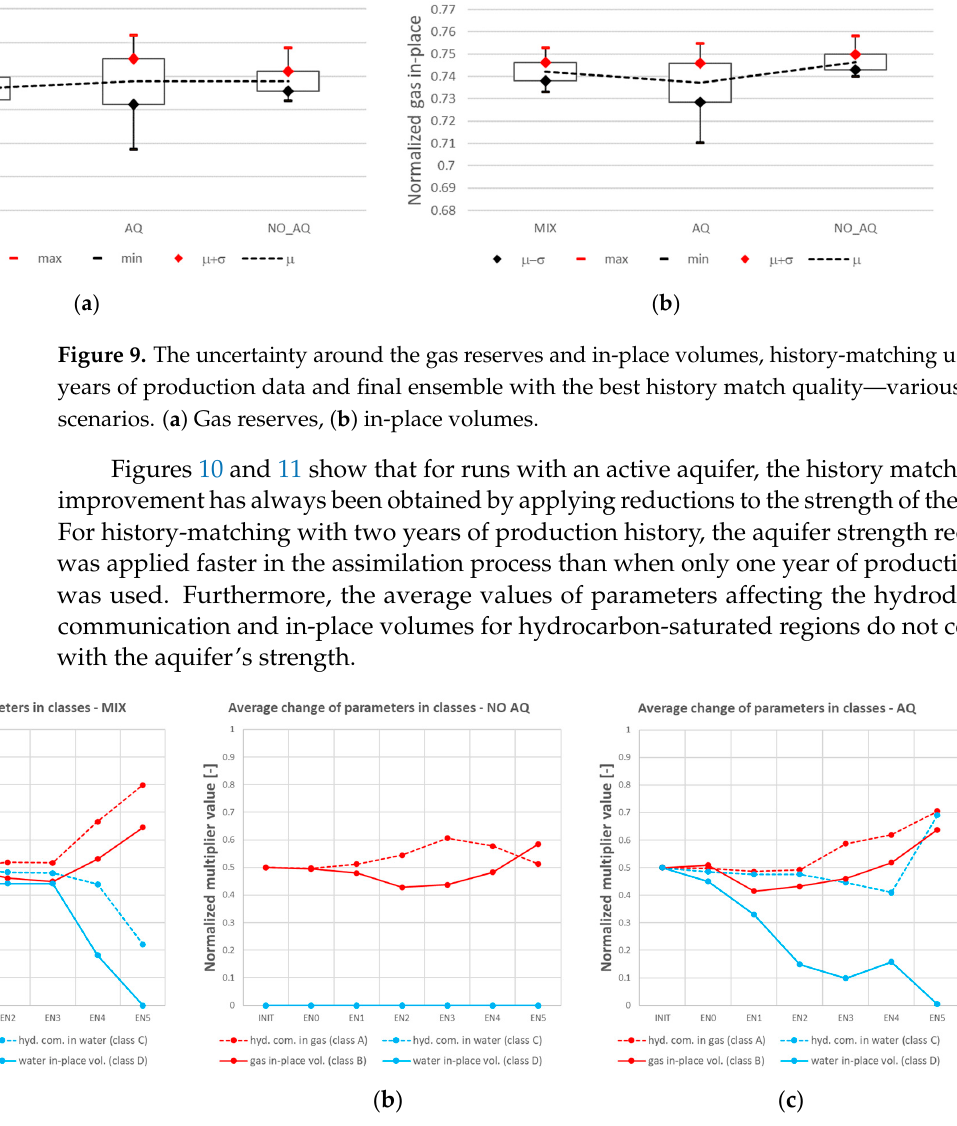
( c ) Figure 11. The average change of parameters during the history-matching, various aquifer scenar- ios—calibration using two years of production data. ( a ) Acenario mix; ( b ) no aquifer; ( c ) aquifer. 5. Discussion The optimization of the initial ensemble sampling was performed by application of the two-level full factorial design combined with the clustering concept. This approach provided sufficient variability within the initial ensemble, hence the ES-MDA could search for potential solutions more efficiently and calibrate the models more accurately. Ultimately, the ensemble’s history-matching quality at the fifth assimilation step was im- proved by 73% compared to the Monte Carlo sampling method. Furthermore, the uncer- tainty around predictions was reduced from circa 20 down to 2 per cent, leading to a 90% improvement. Regarding the history match quality improvement for various aquifer scenarios, the average RMSE for models calibrated using one year of production data was reduced from 10.3 down to 1.65 bar, leading to an 84% enhancement. For models calibrated using two